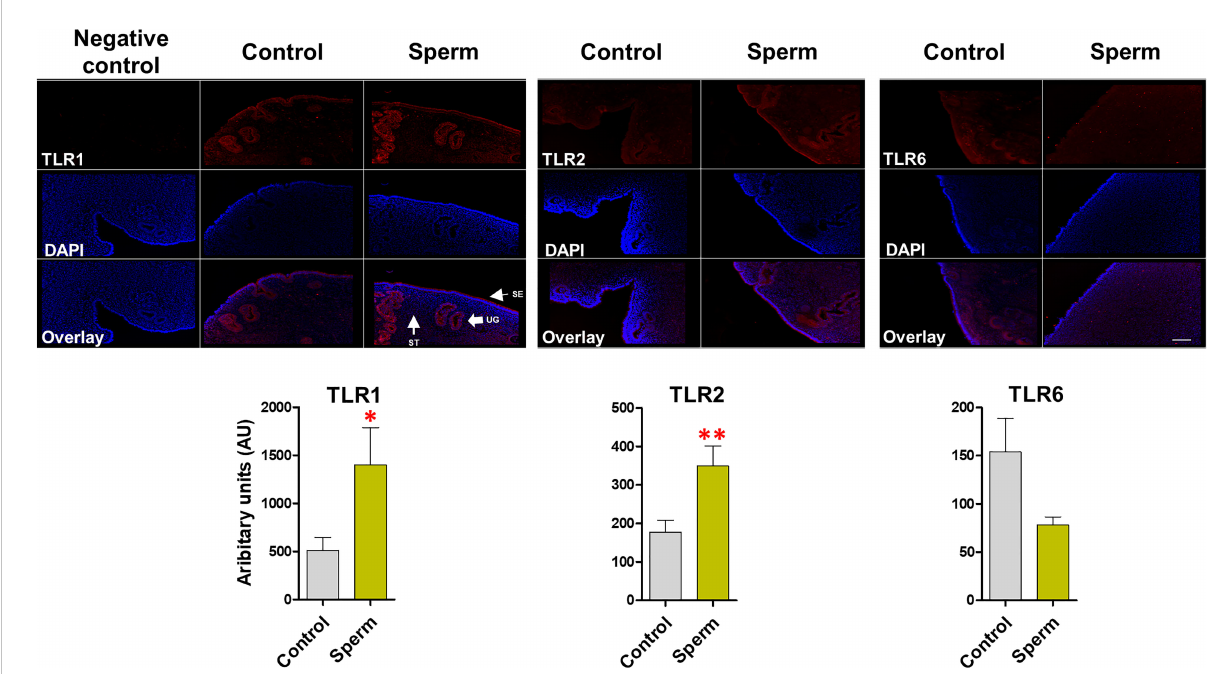
FIGURE 4 Sperm induce TLR2 and TLR1 (not TLR6) protein expression in bovine endometrial explants. The intense expression of TLR1 and TLR2 in uterine glands (UGs) and surface epithelium (SE) in sperm group. This experiment was repeated three times using explants from three different uteri. Asterisks show a signi fi cance of difference (*P < 0.05 or **P < 0.01) in the treatment group when compared to the control group. when compared to the control group. ST, stroma. Bar = 100